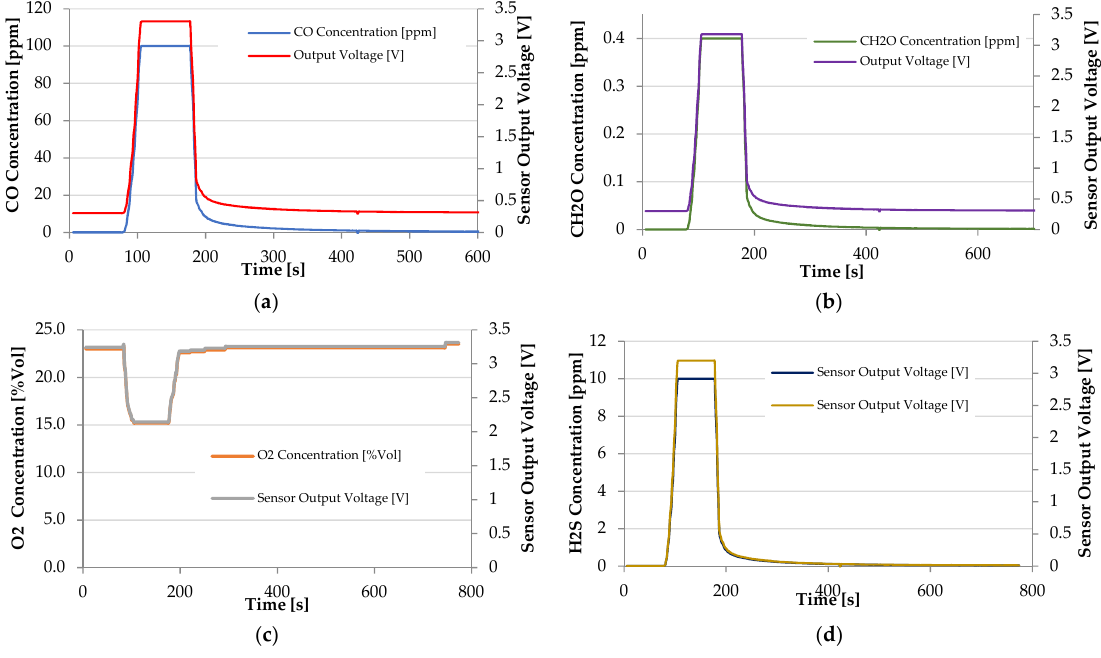
Figure 21. Transient responses of the used electrochemical gas sensors: ME2-CO ( a ), ME2-CH2O ( b ), ME2-O2 ( c ), and ME3-H2S ( d ). Table 3 summarizes the parameters (response time, recovery time, and sensitivity)